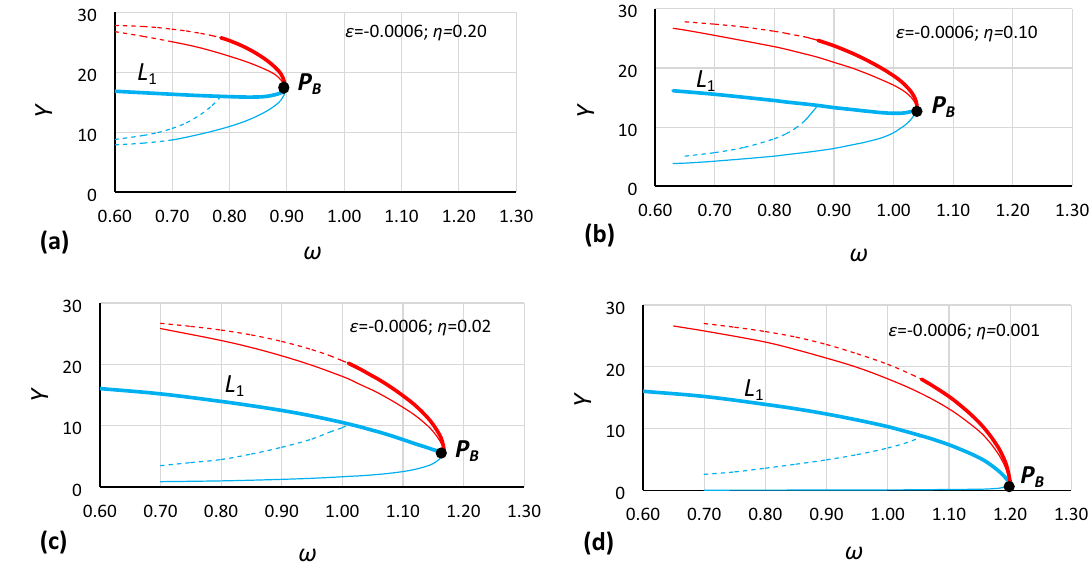
Figure 3. Bistability areas, unstable solution areas and origin point P B of the Duffing equation for nonlinearity ε = − 0.0006. Case A1 ( α = 1.44225; β = − 0.0018) for damping coefficient η : ( a ) 0.20, ( b ) 0.10, ( c ) 0.02, ( d ) 0.001.